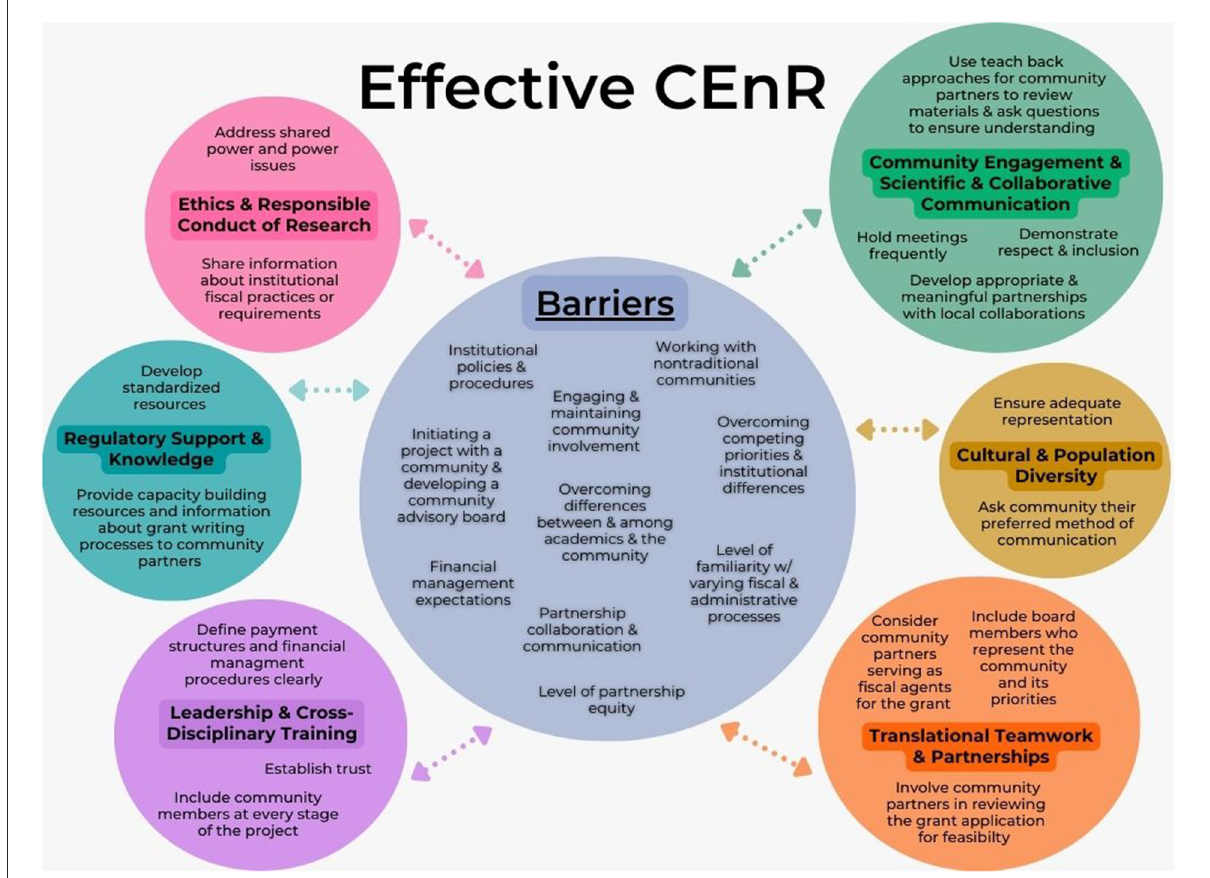
FIGURE1 Breaking institutional and community barriers to achieve effective